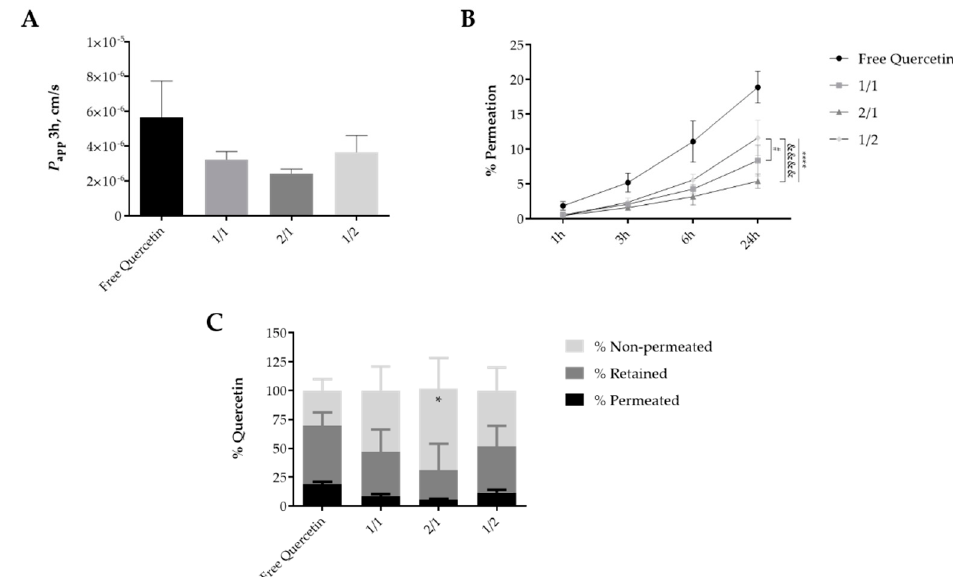
Figure 7. Quercetin permeation profile through the PVPA SC barrier. ( A ) Apparent permeability ( P app ) of quercetin at 3 h; ( B ) Amount of permeated quercetin (%) as a function of time obtained for free quercetin and quercetin-loaded SA-PVA hydrogels. **** p < 0.0001 for all hydrogel formulations vs. free quercetin at 24 h; # p < 0.05 for 1 / 1 vs. 1 / 2 hydrogel formulation and &&&& p < 0.0001 for 2 / 1 vs. 1 / 2 hydrogel formulation both at 24 h. ( C ) Distribution of quercetin among permeated, retained, and non-permeated through the PVPA SC after 24 h. The bars / points represent the mean ± SD of the permeability for at least three independent experiments ( n = 3). * p < 0.05 for 2 / 1 hydrogel formulation vs. other formulations and free quercetin remained in apical medium.